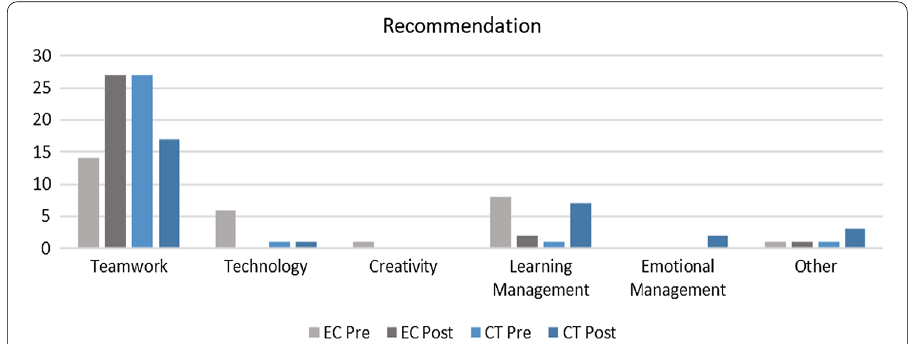
Fig. 12 Graphical representation of recommendations pre and post-intervention for both groups